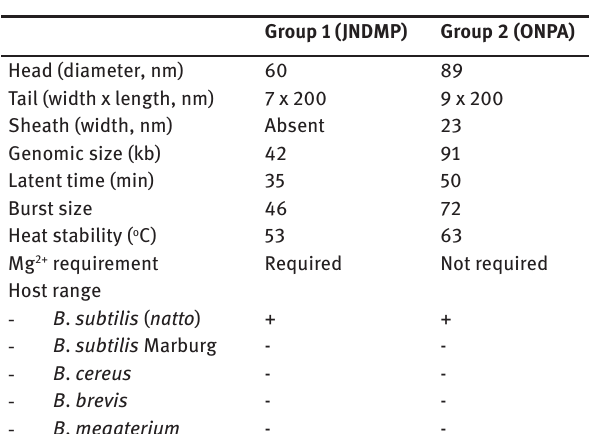
Table 3: Key characteristics of the two Natto phage groups (adapted from 64,